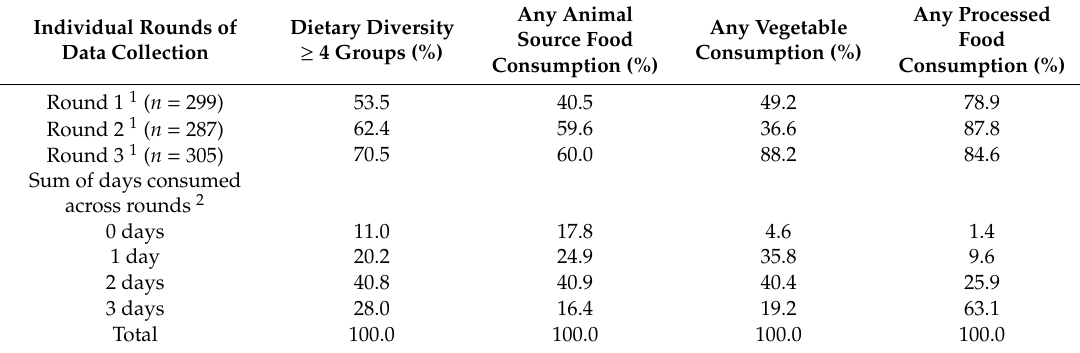
Table 2. Dietary diversity, animal source food consumption and any vegetable consumption in the previous 24 h by round and sum of